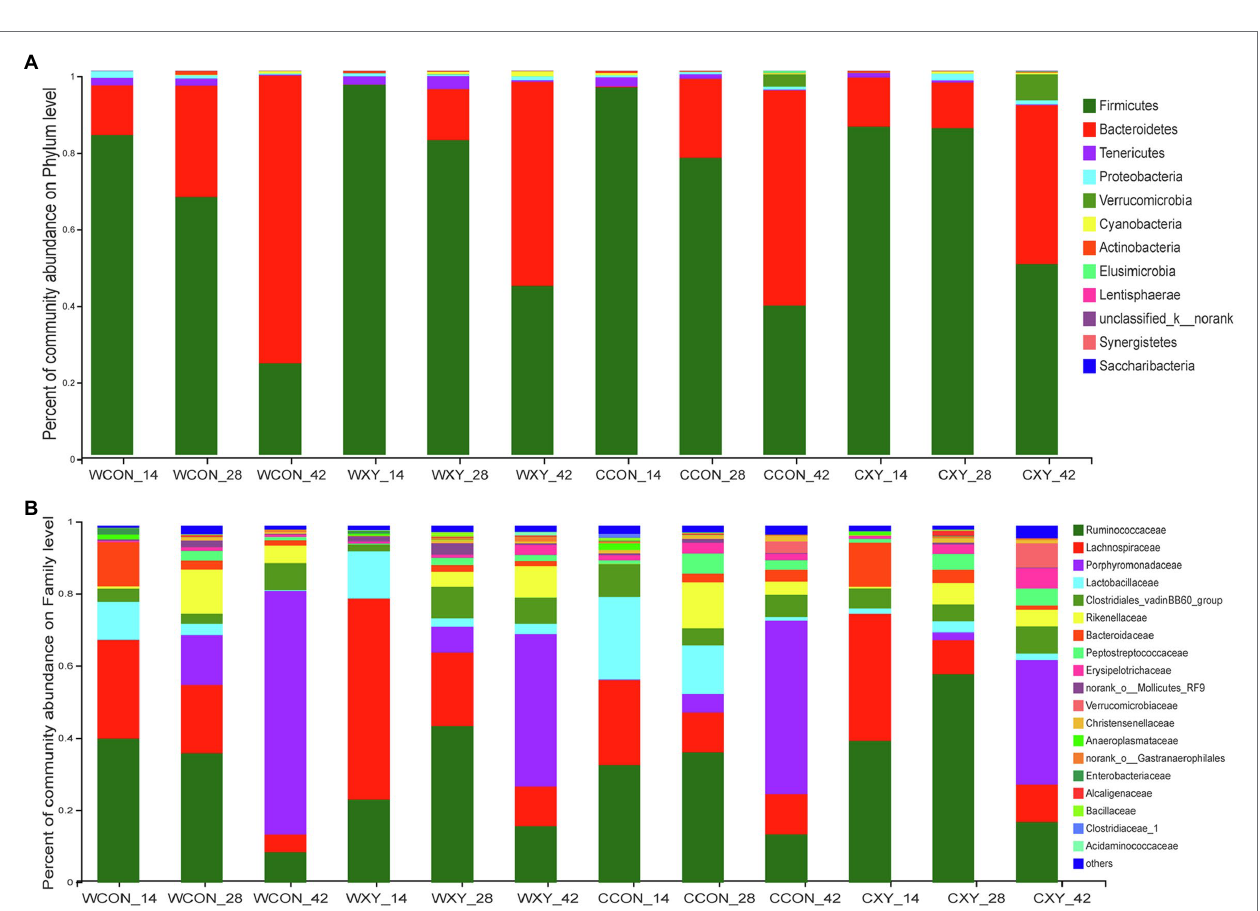
FIGURE 5 | Effects of xylanase on cecal bacteria communities of broilers at phylum and family level. (A) Cecal bacterial community at the phylum level in broilers from four treatments (d 14, d 28, and d 42). (B) Cecal bacterial community at the family level with the relative abundance higher than 0.1% in broilers from four treatments (d 14, d 28, and d 42). Wheat-soybean basal diet (WCON); wheat-soybean basal diet with 4,000 U/kg xylanase (WXY); corn-soybean basal diet (CCON); and corn-soybean basal diet with 4,000 U/kg xylanase